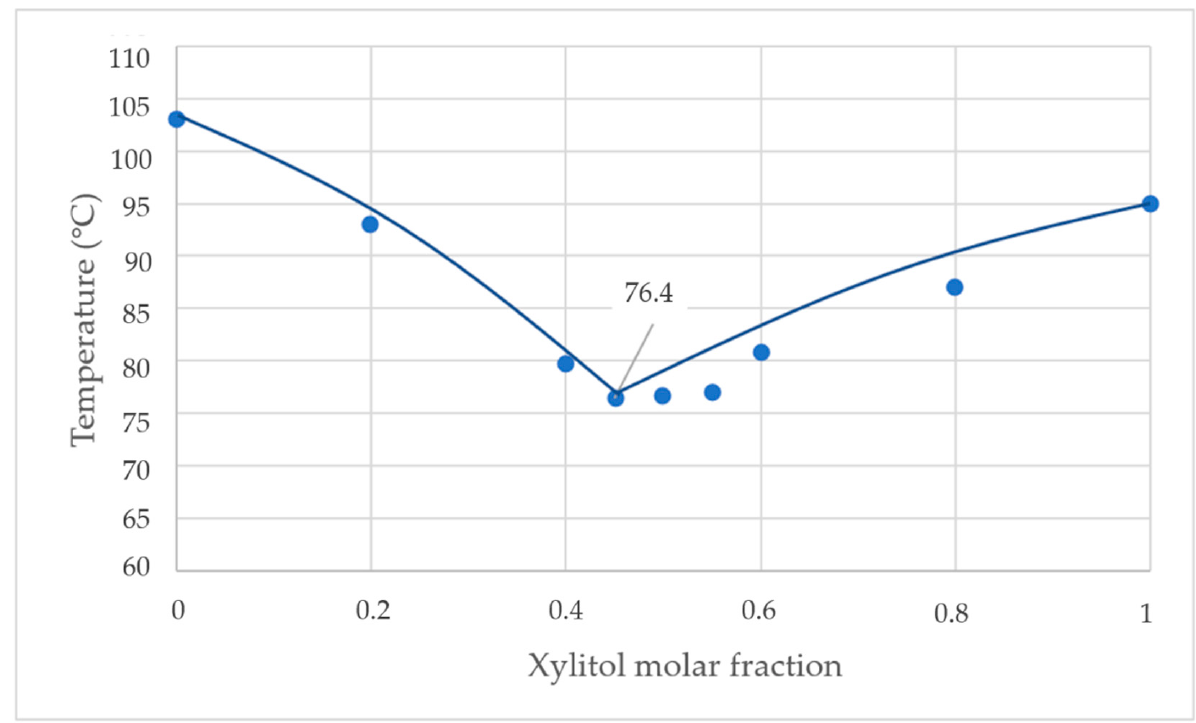
Figure 9. Phase diagram of the xylitol-fructose from DSC. DSC thermograms were used to determine the specific heat capacity, heat of fusion, activity coefficient, and excess Gibb’s energy. Firstly, specific heat capacity and heat of fusion were calculated at the eutectic point was 1.21 J/kg K, using Equation (1), and the heat of fusion was 215 kJ/mol from Equation (2). Secondly, the activity coefficients for xylitol and fructose were calculated using Equations (3) and (4). Lastly, the Excess Gibbs Energy for both xylitol and fructose were calculated using Equation (5). Table 2 shows the activity coefficient and excess Gibb’s energy at different xylitol—fructose proportions. For the eutectic point (bold), xylitol, and fructose had activity coefficients of 2.06 and 1.69. Excess Gibbs Energies of xylitol and fructose were 458 and 332 kJ/kg. The activity coefficient of xylitol and fructose in the liquid phase were 2.07 and 1.69. Table 2. Activity coefficient and Excess Gibbs